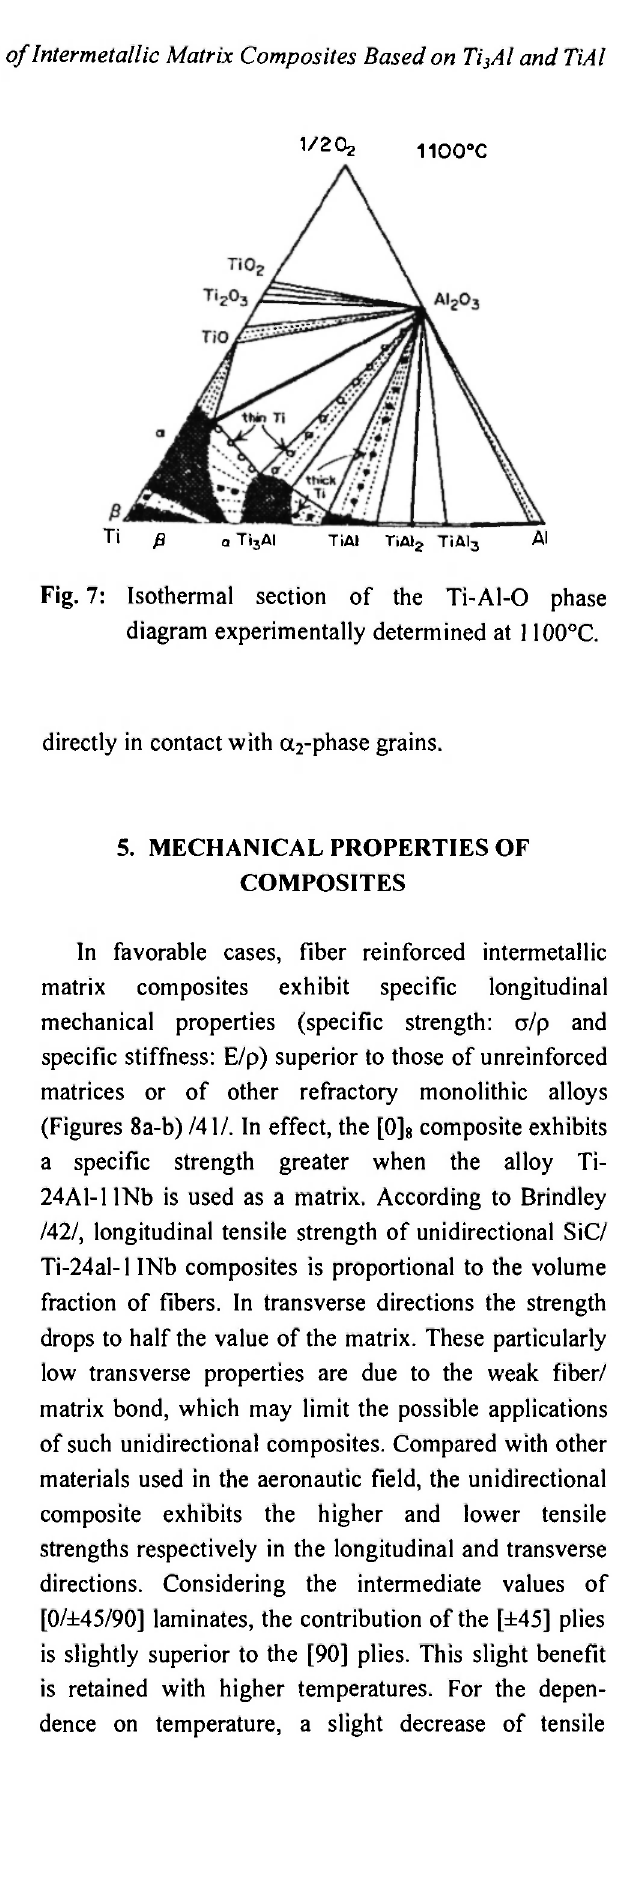
(Figure 7). Systems associating alumina fiber and